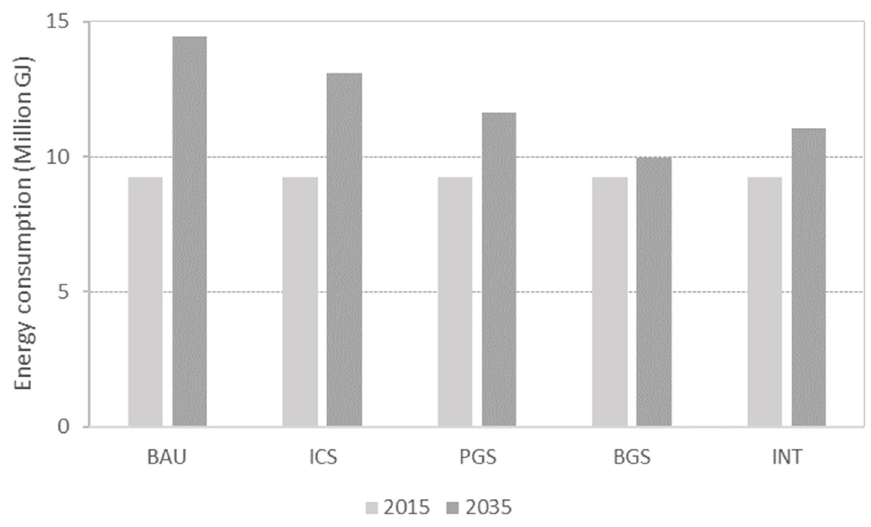
Figure 2. Fuel use in terms of energy consumption as input for the LCA model in the BAU, ICS, PGS, BGS and INT scenarios in 2015 and 2035.